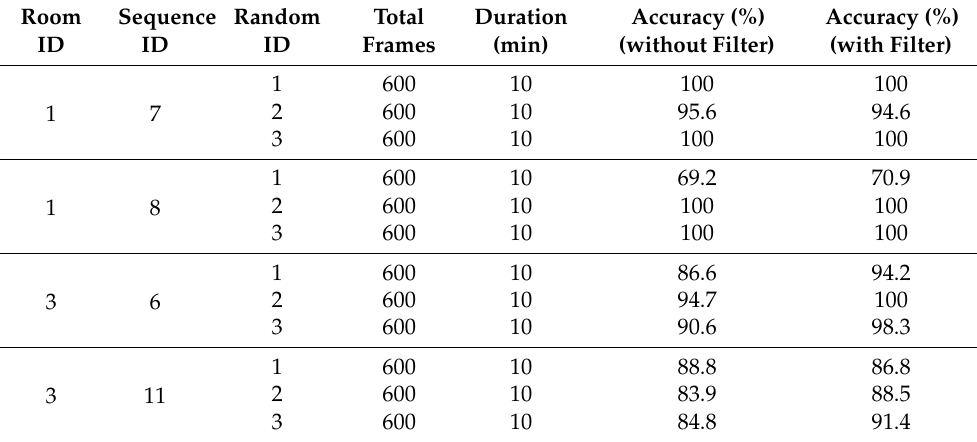
Table 6. Comparison of accuracy for the randomly generated testing sequences.